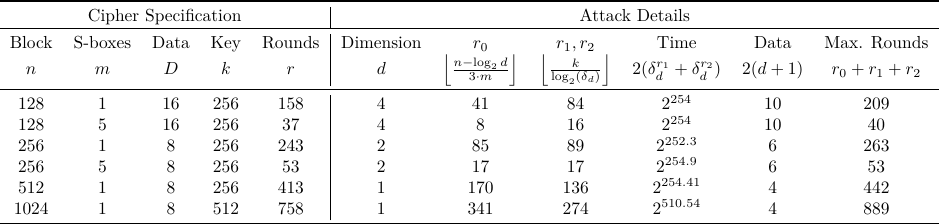
Table 2: Maximum number of attacked rounds for different versions of LowMCv2. Time complexity is in all cases just below what the key size allows. Data is given in number of chosen plaintexts. Block and key size are given in